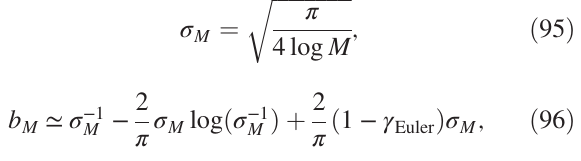
states that are located anomalously close to each other.